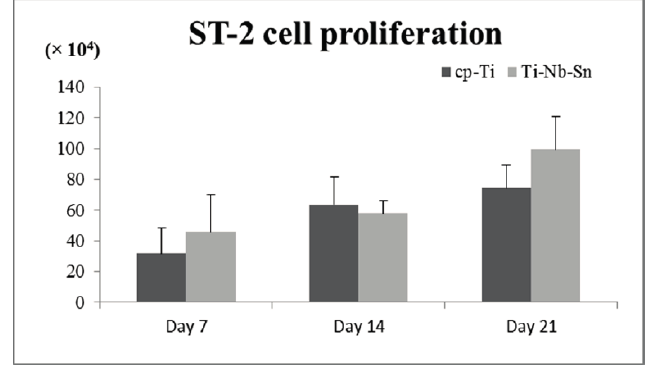
Figure 3. Cell proliferation assay. Data are the mean ± SD ( n =